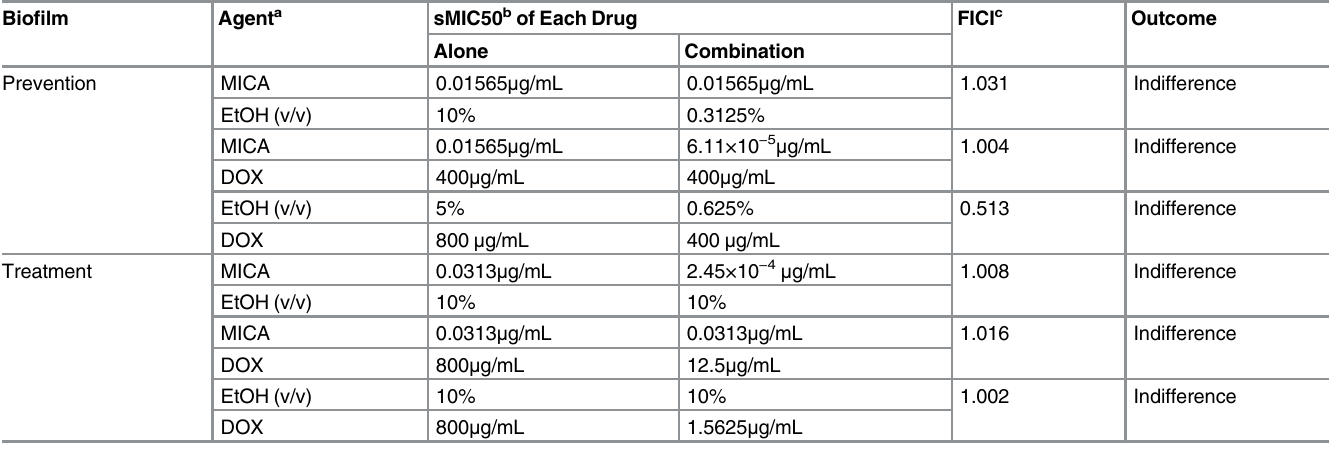
Table 2. Antifungal activity of two-drug combinations against forming and mature C . albicans biofilms, sMIC50. Bio fi